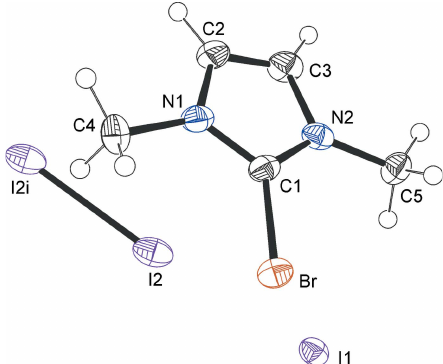
Figure 2 The molecular structure of the iodide 2 , showing the atom labels and 50% probability displacement ellipsoids for non-H atoms. [Symmetry codes: (i)